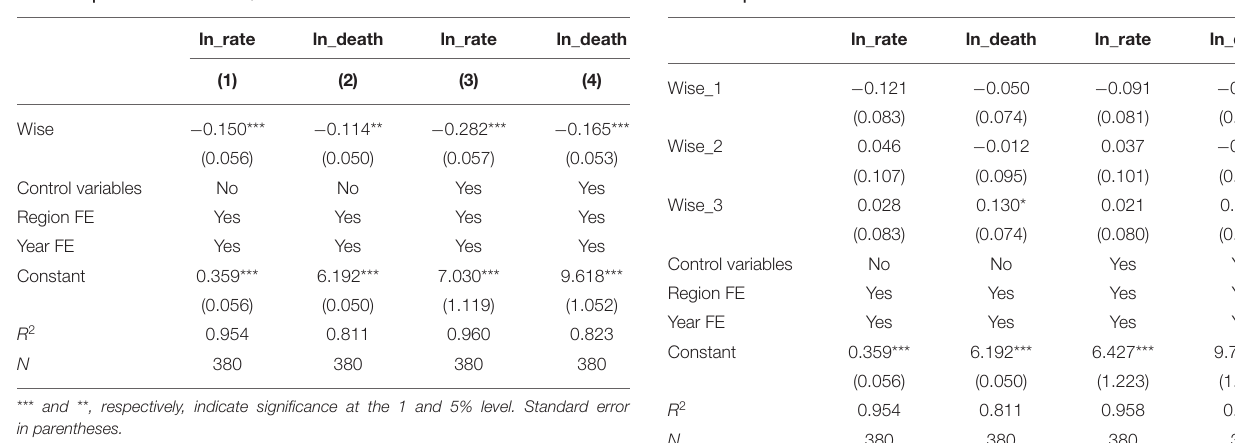
TABLE 4 | Results of the PSM + DID model. TABLE 5 | Results of falsification test.